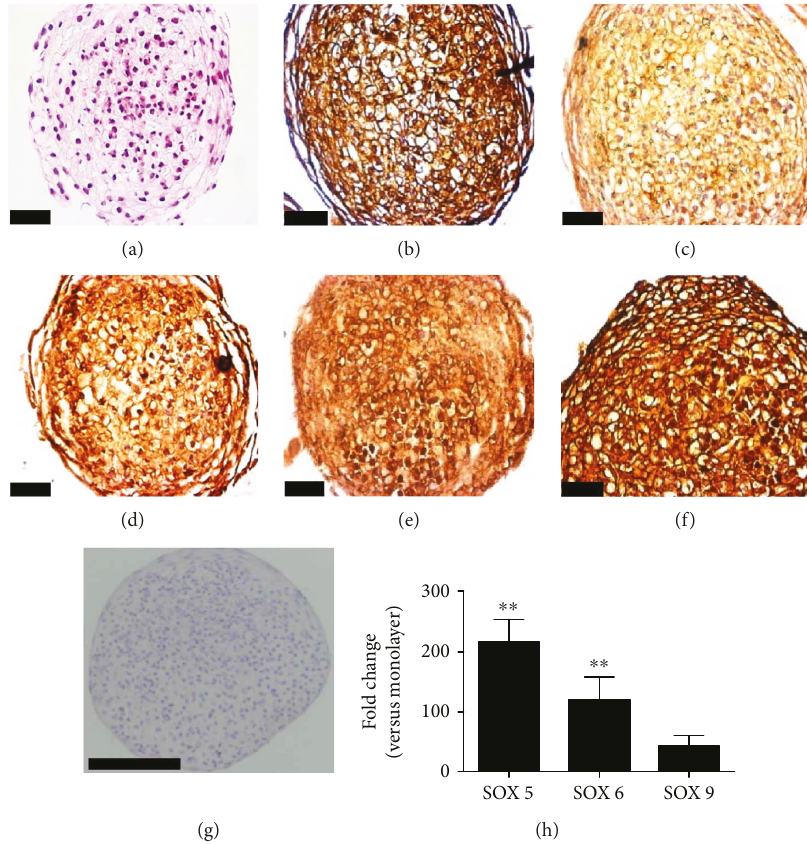
Figure 6: The CPC spheroids after spontaneous chondrogenesis are strongly positive for typical markers of cartilage tissue. (a) Hematoxylin and Eosin staining revealed rather rounded cells inside the spheroid. (b) N-cadherin is strongly present; (c – f) extracellular matrix typical markers of cartilage are shown throughout the spheroid area; (c) collagen type II; (d) collagen type VI; (e) aggrecan; (f) chondroitin sulfate. Bar size: 20 μ m. (g) Control of nonspeci fi c binding of secondary antibody (immune reaction carried out in the absence of the primary antibody). All reactions were done in the same moment. Bar size: 100 μ m; μ m: micrometers. (h) qPCR analysis of CPC spheroids showing upregulation of the SOX5 and SOX6 genes comparing to monolayer after 21 days of cell culture ( ∗∗ p < 0 01 ). The expression of SOX9 gene was not statistically signi fi cant ( p = 0 05293 ). Standard errors are